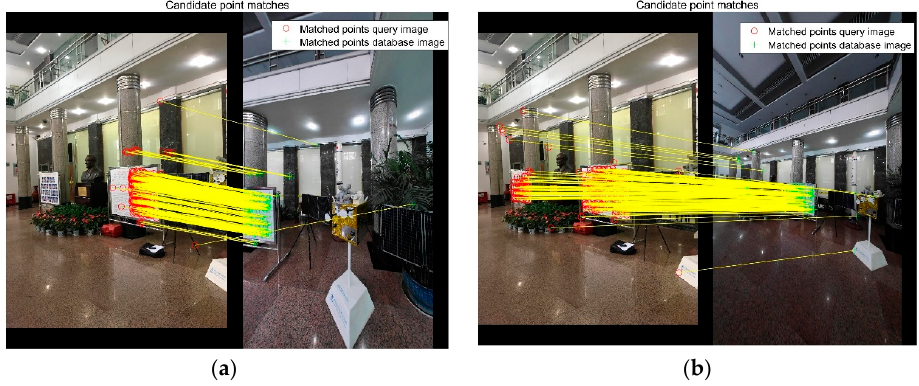
Figure 6. Matches after geometry check. ( a ) Most matched image with 390 matches. ( b ) A uniform distribution with 339 matches.